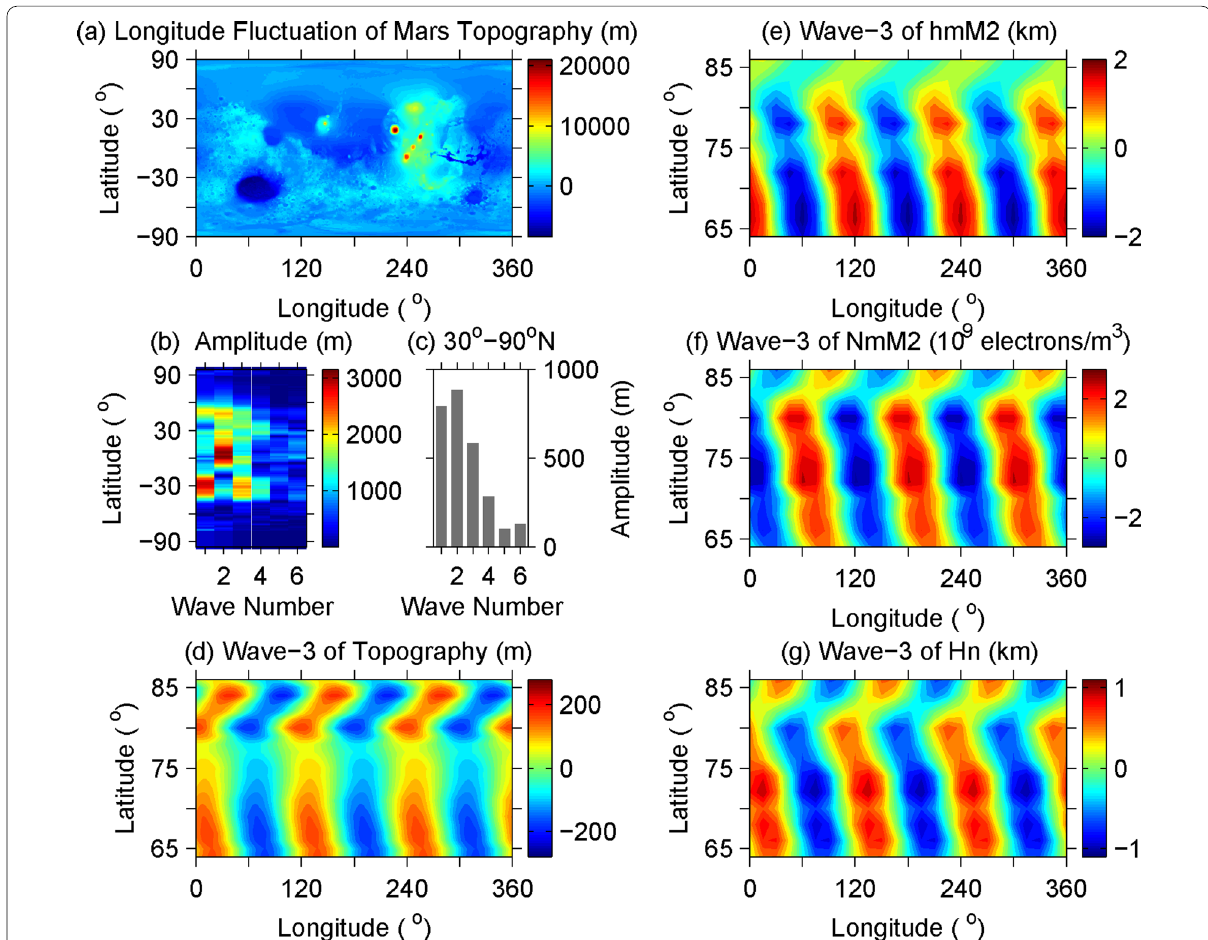
Fig. 5 Comparison between Martian topography and ionospheric and thermospheric longitude variations. a Shows Martian topographic fluctuations; b presents latitude variations of the amplitudes of topographic longitude wave longitude wave 1 to 6 over the latitude range of 30–90°N; d shows topographic longitude wave − − longitude wave 3 in h m M 2 , N m M 2 , and H n , −